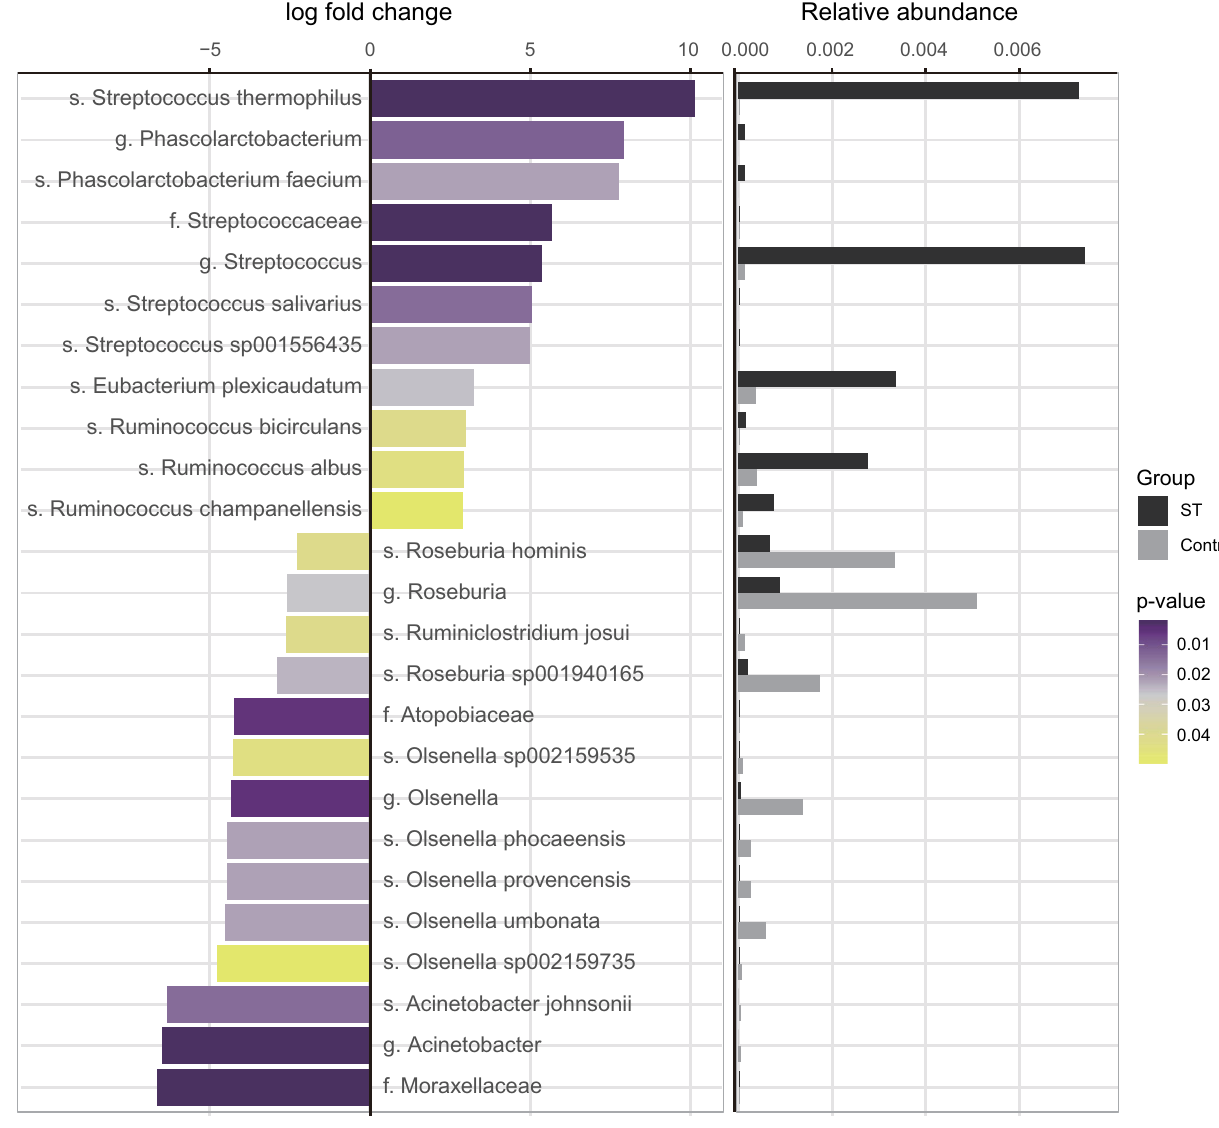
Figure 4. Significantly modulated gut microbiota by S. thermophilus EG007 consumption. For detection of significantly altered taxonomic units, negative binomial based generalized linear model (GLM) was employed using EdgeR with trimmed mean of M-value (TMM) normalization method, and significance was defined by P -value < 0.05. For each of the altered taxonomic units, log(Fold change) was shown in the left panel, and the relative abundance was presented on the right